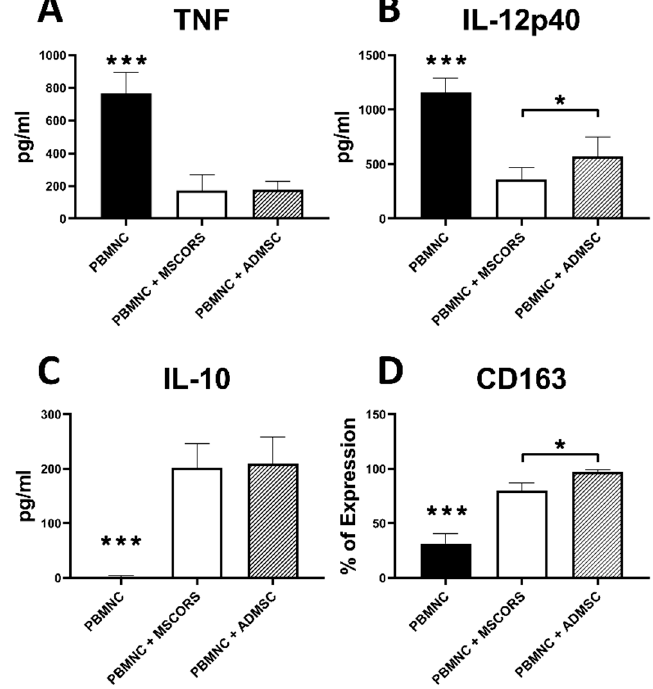
Figure 4. Immunomodulatory effects of MSCORS and ADMSC with stimulated PBMNC alone or in co-culture. MSCORS and ADMSC ( n = 3) were pre-seeded and co-cultured with CD14 + PBMNC monocytes with 6 days GM-CSF stimulation and 1 day of treatment of LPS to obtain differentiated macrophages. CD14 + PBMNC-derived macrophages were counted by flow cytometry and levels of released cytokines including TNF- α , IL-12p40 and IL-10 were assessed by ELISA. ( A ) TNF- α , ( B ) IL-12p40, ( C ) IL-10, ( D ) CD163 expression. Data are depicted as mean ± SD (* p < 0.05, *** p < 0.001). *** asterisks above PBMNC signifies statistical difference versus all other groups.